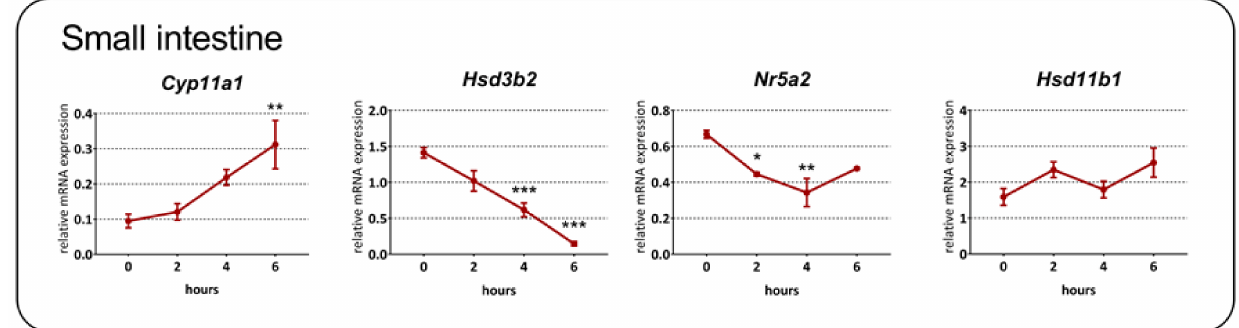
Figure 1. Kinetics of glucocorticoid-related gene expression in the small intestine of specific pathogen-free mice following anti-CD3 antibody injection. Cyp11a1 , cholesterol side-chain cleavage enzyme; Hsd3b2 , 3 β -hydroxysteroid dehydrogenase type 2; Nrp5a2 , liver receptor homolog-1, Hsd11b1 , 11 β -hydroxysteroid dehydrogenase type 1. The data are expressed as means ± SEM. Statistical significance at levels * p < 0.05, ** p < 0.01, *** p < 0.001 vs. control group at time